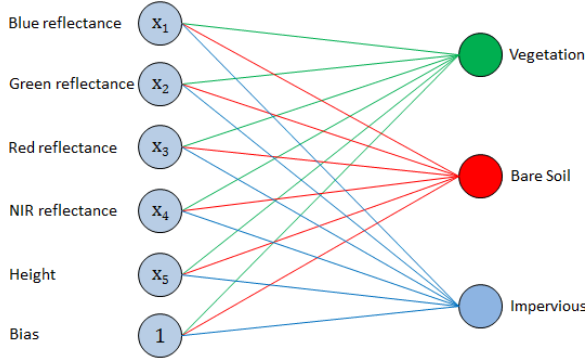
Figure 2. Example of a Softmax Regression model with five attributes and three classes.